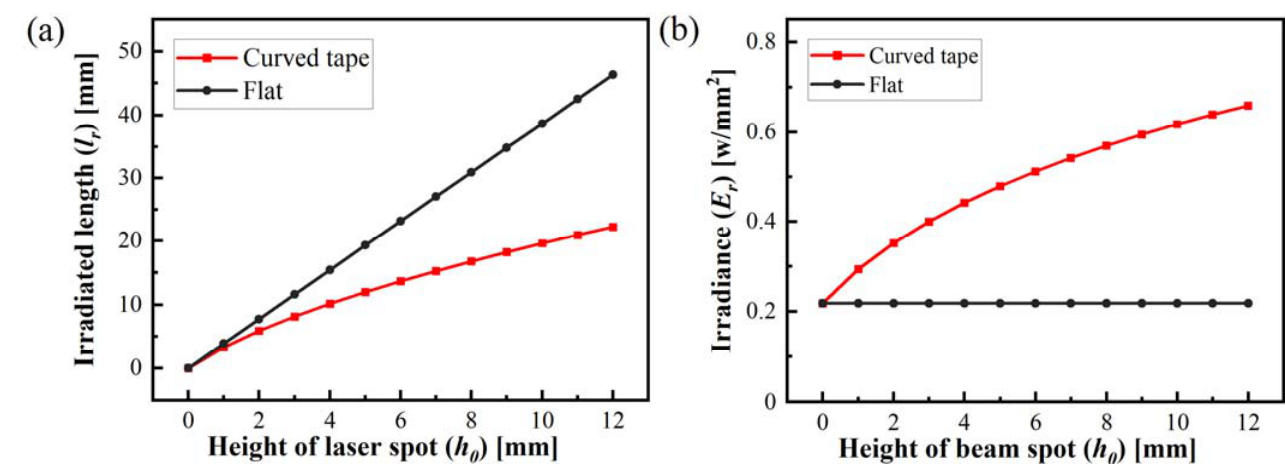
Figure 7. Quantitative graphs of irradiated length ( a ) and irradiance ( b ) variations based on Equations (4) and (5).